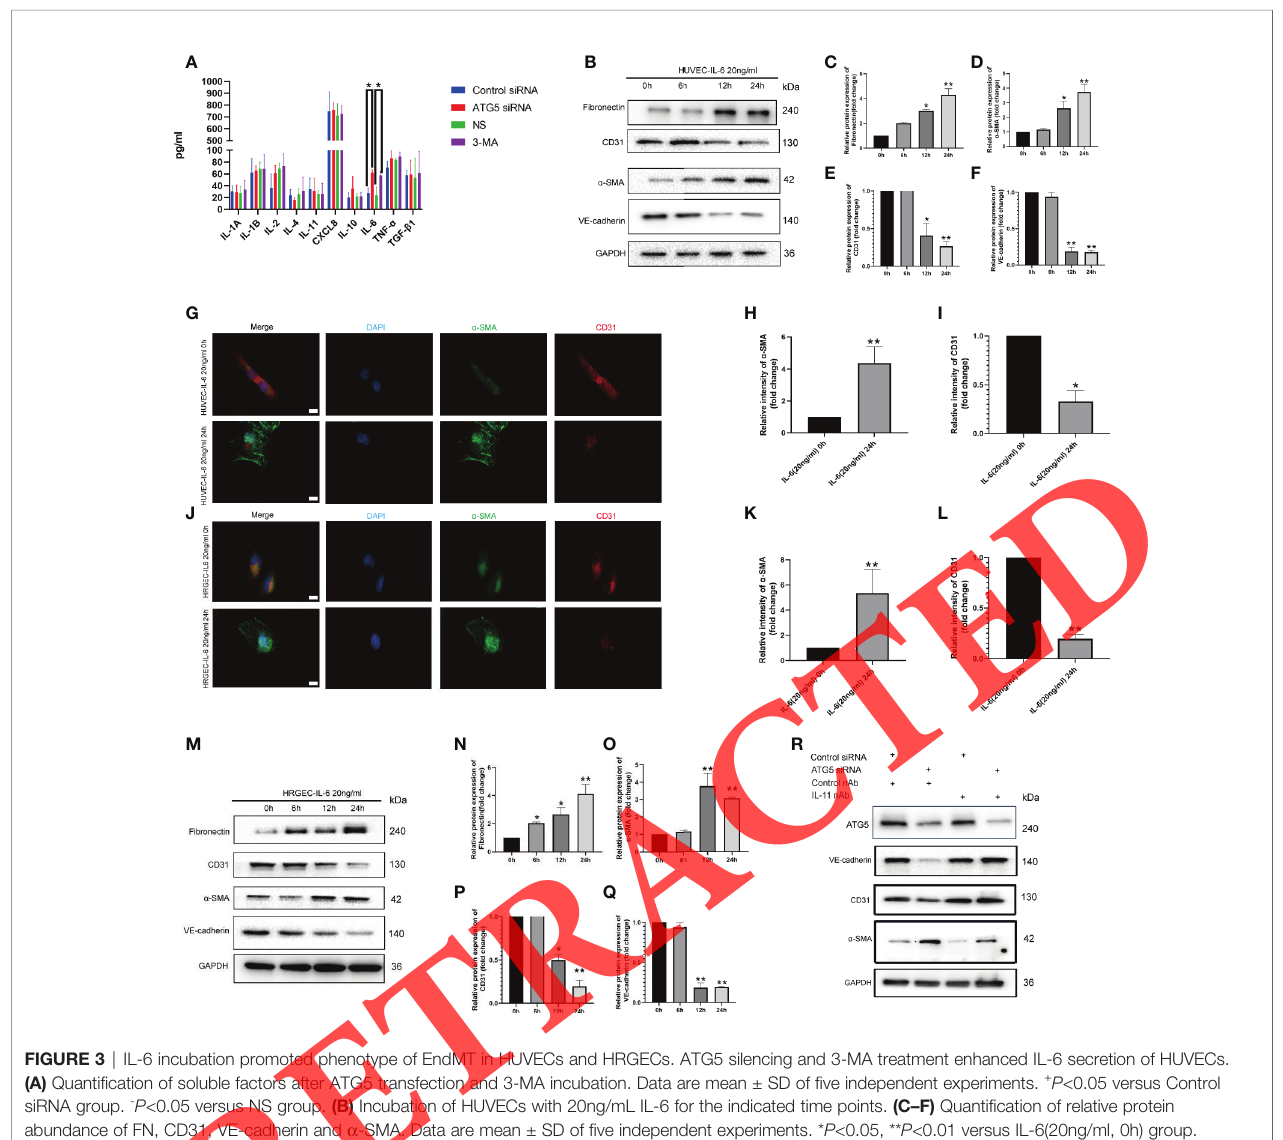
FIGURE 3 | IL-6 incubation promoted phenotype of EndMT in HUVECs and HRGECs. ATG5 silencing and 3-MA treatment enhanced IL-6 secretion of HUVECs. (A) Quanti fi cation of soluble factors after ATG5 transfection and 3-MA incubation. Data are mean ± SD of fi ve independent experiments. + P <0.05 versus Control siRNA group. - P <0.05 versus NS group. (B) Incubation of HUVECs with 20ng/mL IL-6 for the indicated time points. (C – F) Quanti fi cation of relative protein abundance of FN, CD31, VE-cadherin and a -SMA. Data are mean ± SD of fi ve independent experiments. * P <0.05, ** P <0.01 versus IL-6(20ng/ml, 0h) group. (G) Representative immuno fl uorescence staining of CD31 and a -SMA in HUVECs. Bar=20 m m. (H, I) Quanti fi cation of relative intensity of CD31 and a -SMA in HUVECs. Data are mean ± SD of fi ve independent experiments. * P <0.05, ** P <0.01 versus IL-6(20ng/ml, 0h) group. (J) Representative immuno fl uorescence staining of CD31 and a -SMA in HRGECs. Bar=20 m m. (K – L) Quanti fi cation of relative intensity of CD31 and a -SMA in HRGECs. Data are mean ± SD of fi ve independent experiments. * P <0.05, ** P <0.01 versus IL-6(20ng/ml, 0h) group. (M) Incubation of HUVECs with 20ng/mL IL-6 for the indicated time points. (N – Q) Quanti fi cation of relative protein abundance of FN, CD31, VE-cadherin and a -SMA. Data are mean ± SD of fi ve independent experiments. * P <0.05, ** P <0.01 versus IL-6(20ng/ml, 0h) group. (R) IL-6 nAb alleviated ATG5 siRNA induced